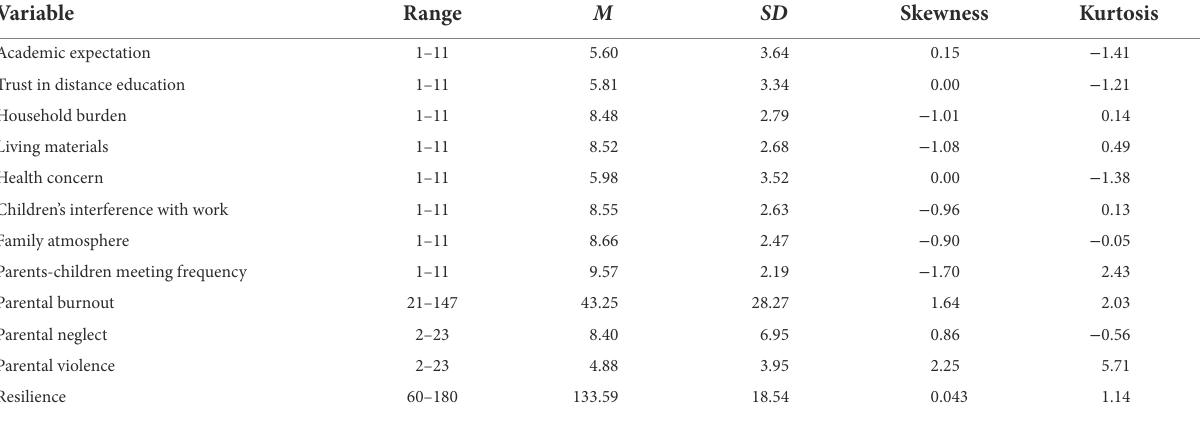
TABLE 1 Ranges, means, and standard deviations for all variables ( N =